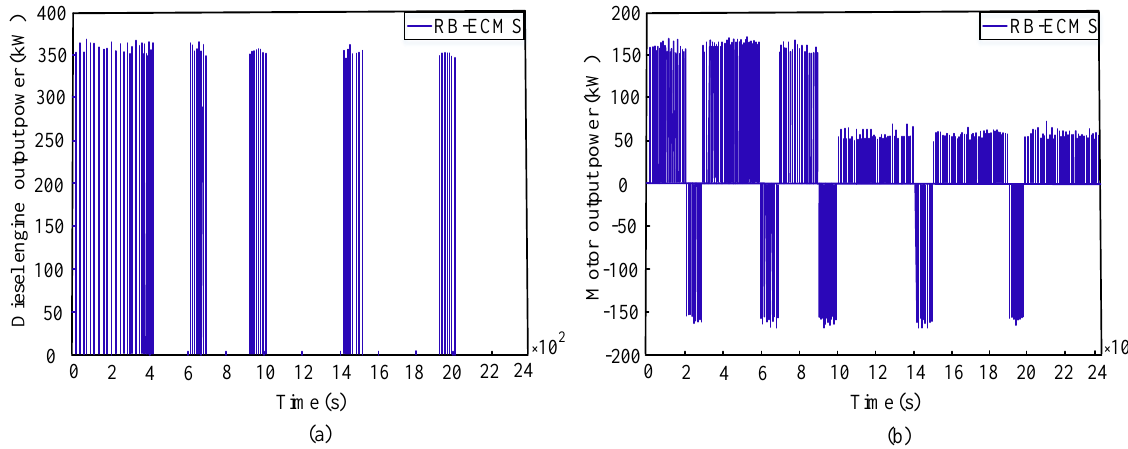
Figure 12. ( a ) Power distribution of rule-based (RB)-ECMS strategy diesel engine under the T condition. ( b ) Power distribution of RB-ECMS strategy motor under the T condition.